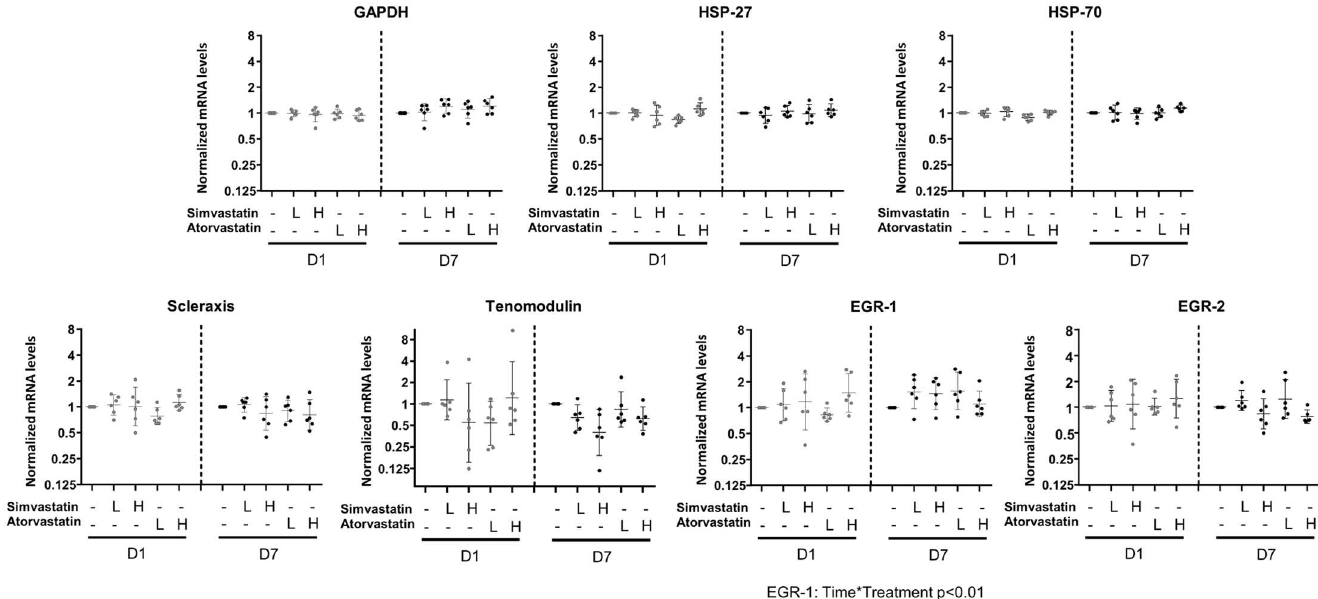
Fig 5. Gene expression analysis: Effect of treatment on GAPDH, heat shock proteins and tendon related genes. Gene expressionafter 1 or 7 days of statin treatment. The sampleswere analyzedfor GAPDH, heat shock proteinsand tendon related genes. Low dose (L) statin treatment corresponds to 0.05 μ Mof either simvastatin or atorvastatinand high dose (H) corresponds to 0.5 μ M. The DMSO-control is set as baseline, and mRNA expressionin constructs treated with statins are shown relative to DMSO-control for each cell line and day. Data is presentedon a logarithmic y scale as geometric means ± 95% confidenceinterval (CI). Individualdonor-specific cell lines are representedby dots. Significant interactionin the repeated measures2-way ANOVA (time * treatment) are below each graph.